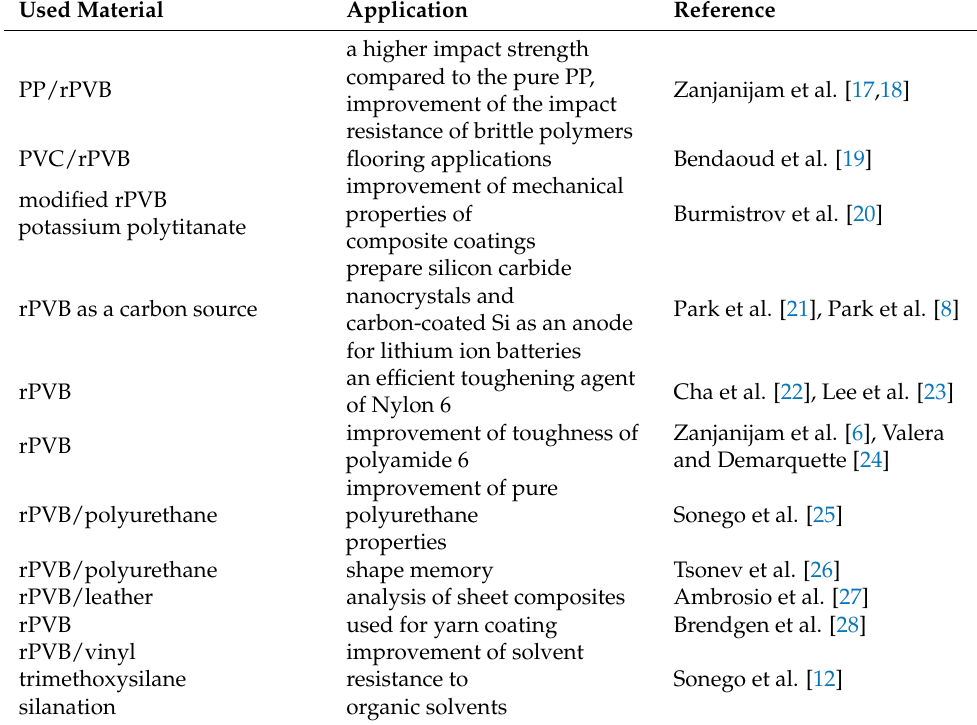
Table 1. Various applications of